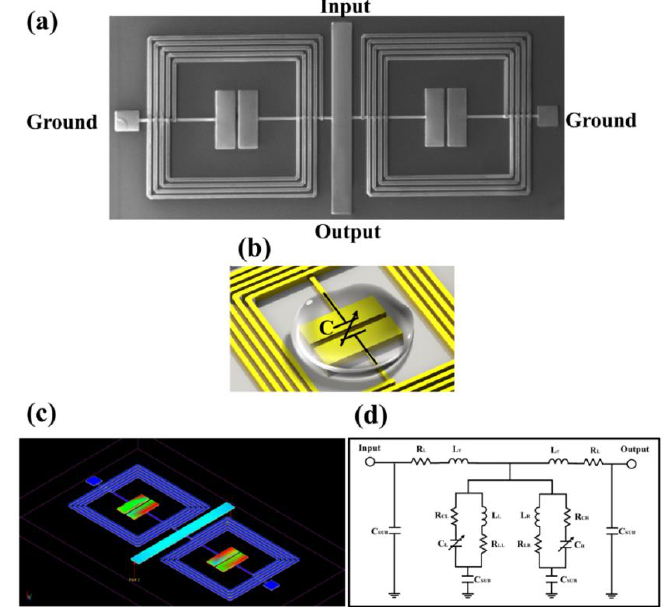
Figure 1. The illustration of glucose biosensor based on the RF resonator. ( a ) The SEM image of the fabricated biosensor with ports description. ( b ) The sensitive area of the hammer-shaped capacitor. ( c ) The simulated electric field distribution for the proposed biosensor at the resonance frequency. ( d ) The equivalent circuit model of the proposed biosensor.